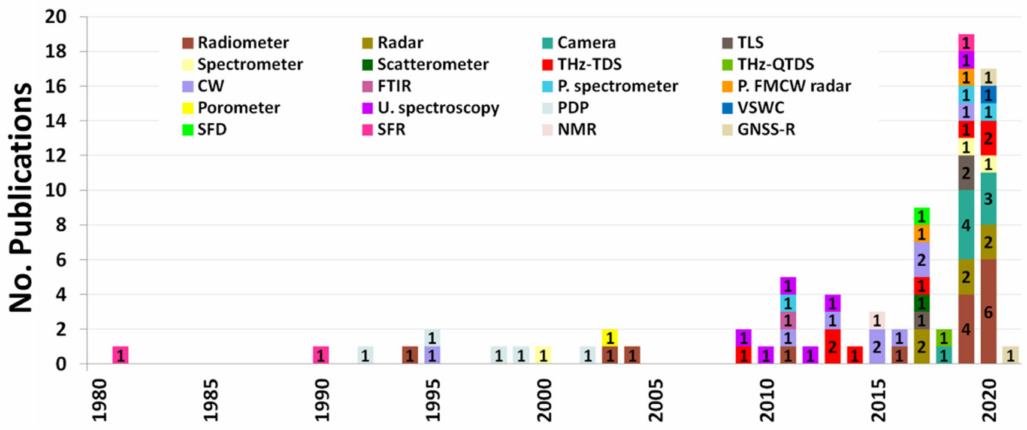
Figure 9. Stacked bar chart including the number of publications for each year and the technologies employed to de- velop the monitoring function. CW = Continuous-wave spectroscopy, FMCW = Frequency-modulated continuous-wave, FTIR = Fourier transform infrared, GNSS-R = Global navigation satellite system-reflectometry, NMR = Nuclear magnetic resonance, P = Portable, PDP = Portable dielectric probe, QTDS = Quasi time domain spectroscopy, SFD = Sap-flux density, SFR = Sap-flow rate, TDS = Time domain spectroscopy, TLS = Terrestrial laser scanning, U. = Ultrasonic, VSWC = Volumetric soil water